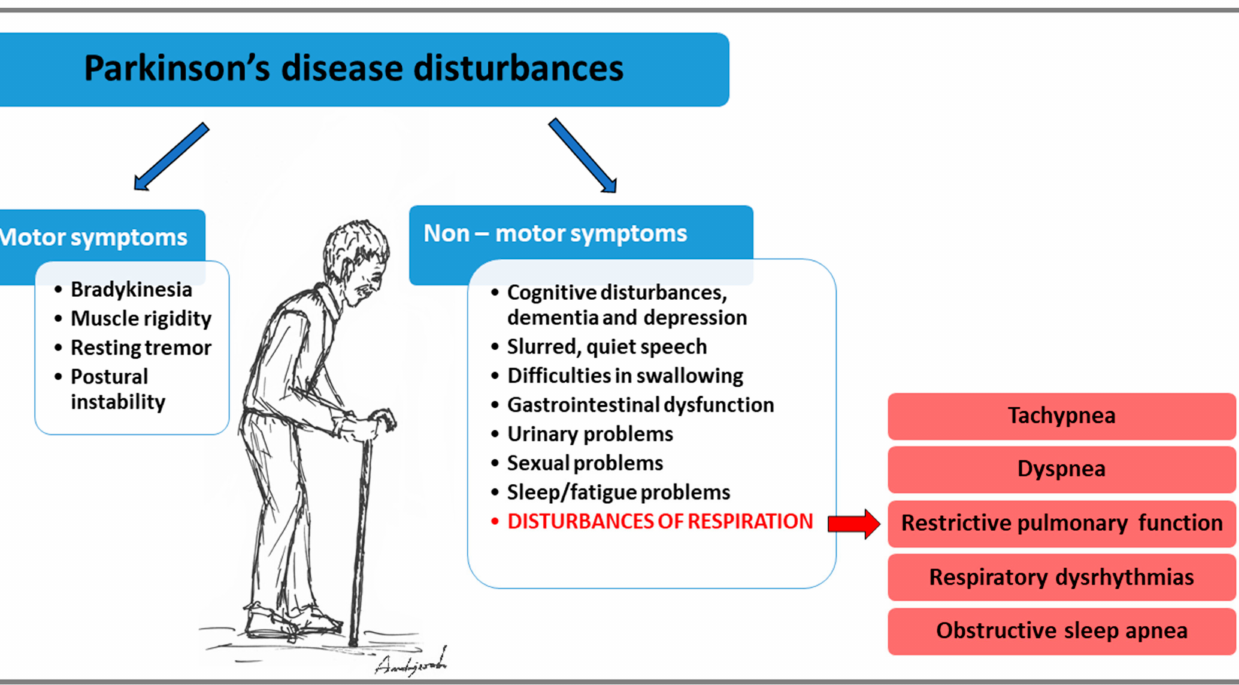
Figure 1. Motor and non-motor symptoms appearing in Parkinson’s disease (PD). Respiratory impairments are present among the non-motor